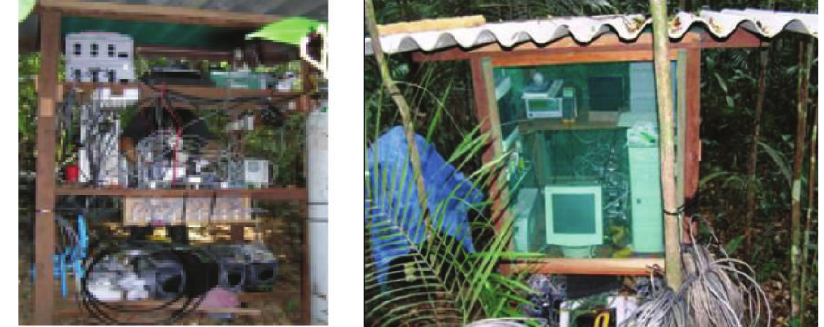
Figure 3: DRAINO measurement system used in Manaus LBA (south face; see also Figure 4).